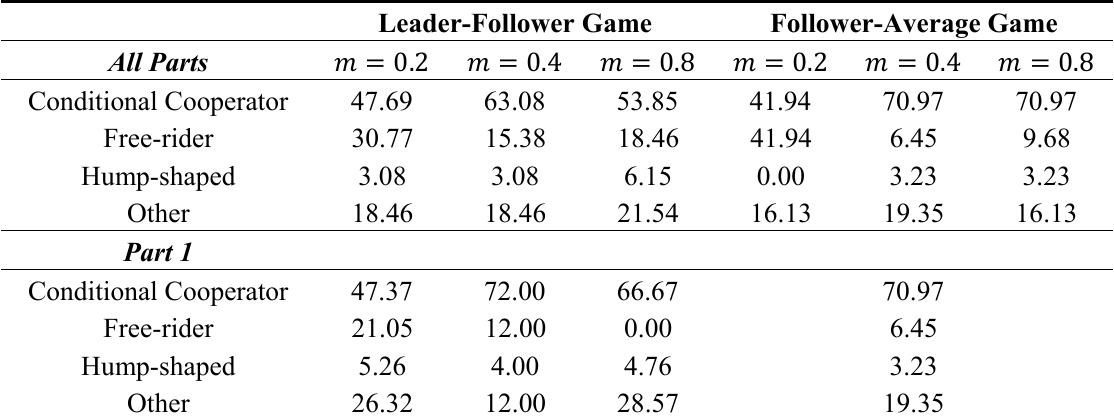
Table 2. Proportion of subjects of each behavioral type for the six different